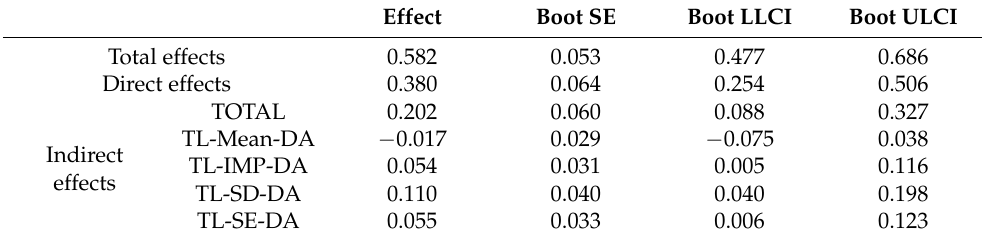
Table 4. Total, direct, and indirect effects of TL on deep